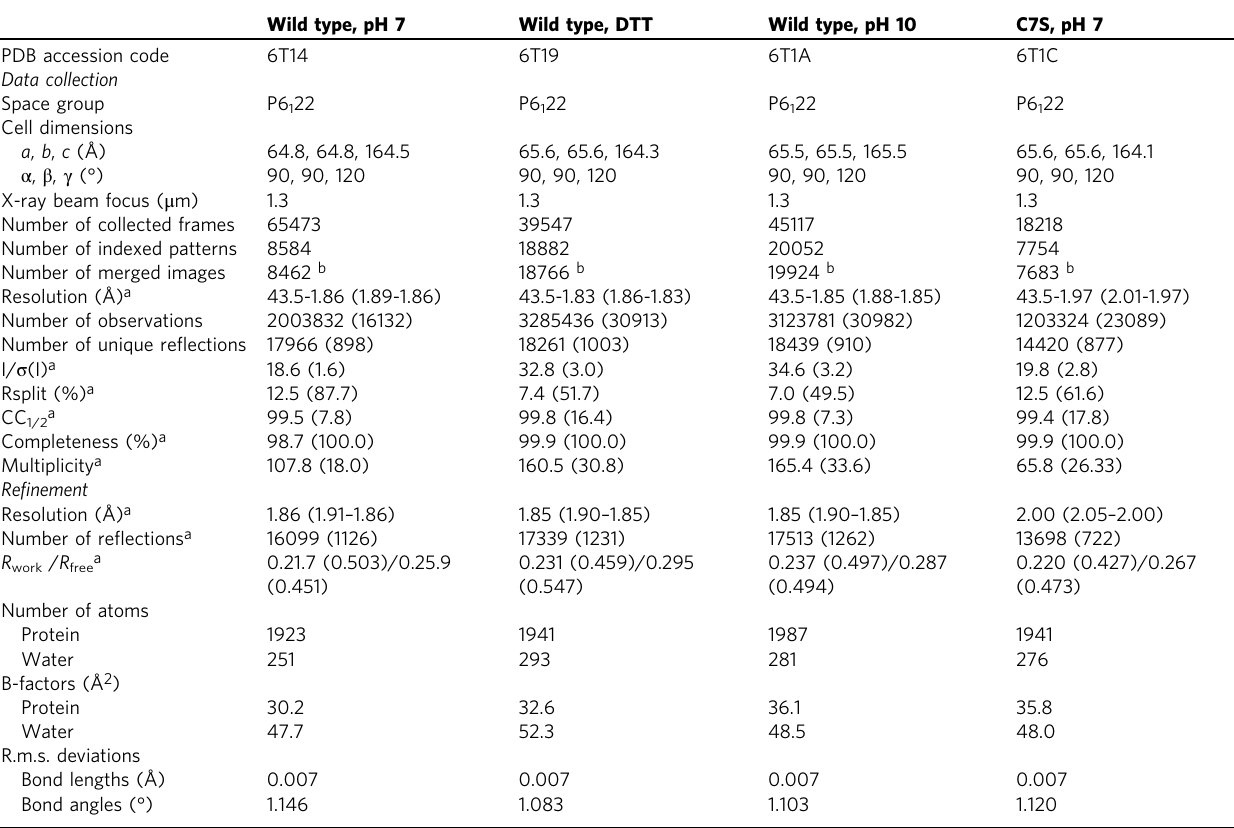
Table 1 Data collection and re fi nement statistics (molecular